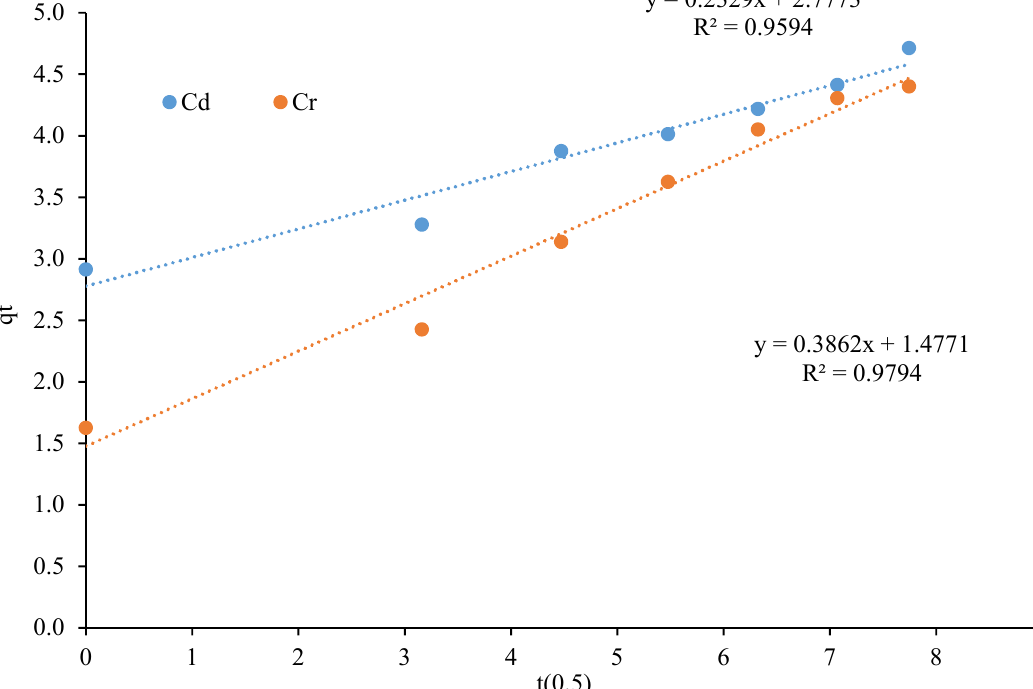
Figure 11. Intra-particle diffusion plot of metal adsorption on the CeO 2 /corncob nanocomposite.